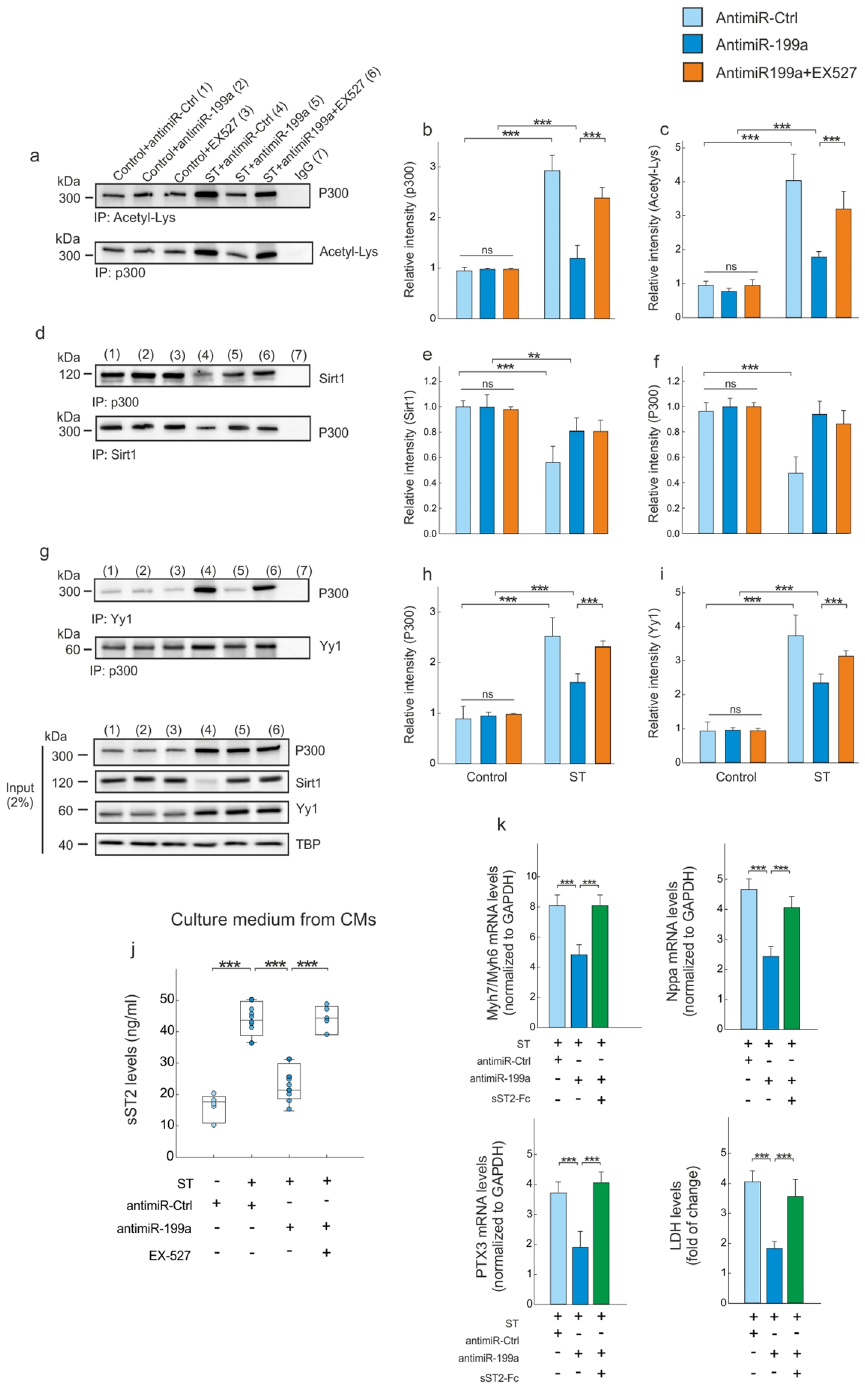
Figure 7. P300 deacetylation prevents Yy1 activation leading to sST2 down-regulation. ( a ) Co-immunoprecipitation of the P300-acetyl-Lys complex in control and stretched CMs that were treated with PBS, antimiR-Ctrl or antimiR-199a. ( b ) Densitometric analysis of the co-immunoprecipitated P300 protein. ( c ) Densitometric analysis of the co-immunoprecipitated acetyl-Lys. ( d ) Co-immunoprecipitation of the Sirt1/P300 complex in control and stretched CMs that were treated with PBS, antimiR-Ctrl or antimiR-199a. ( e ) Densitometric analysis of the co-immunoprecipitated Sirt1 protein. ( f ) Densitometric analysis of the co-immunoprecipitated P300 protein. ( g ) Co-immunoprecipitation assay of the P300/Yy1 complex in control and stretched CMs that were treated with PBS, antimiR-Ctrl or antimiR-199a. ( h ) Densitometric analysis of the co-immunoprecipitated P300 protein. ( i ) Densitometric analysis of the co-immunoprecipitated Yy1protein. ( j ) sST2 protein levels in supernatant from CMs under stretching. ( k ) Quantitative real-time PCR analysis of molecular markers for cardiac myocyte hypertrophy (Myh7/Myh6, Nppa) and cardiac death (PTX3, LDH); sST2-Fc (100 nM) is added 30 min after antimiR- 199a therapy. Representative full western blot images are shown in supplementary material. All quantifications derive from n = 10 independent assays/group. All quantitative data are reported as means ± SEM. ***P < 0.001 determined by two-way ANOVA followed by Bonferroni’s post hoc test. PTX3: pentraxin 3; other abbreviations as in Figs. 2 and